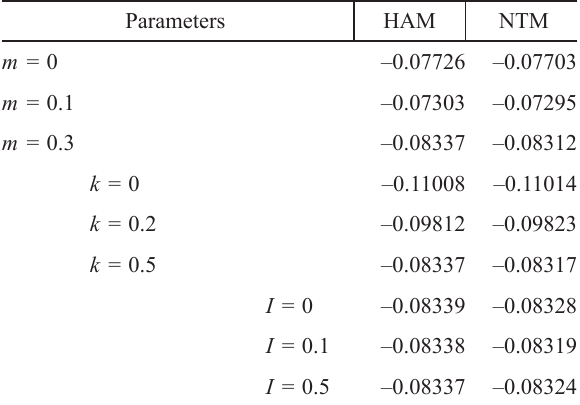
Table 3 – Effect of parameters on secondary skin friction, (Re) 1/2 C